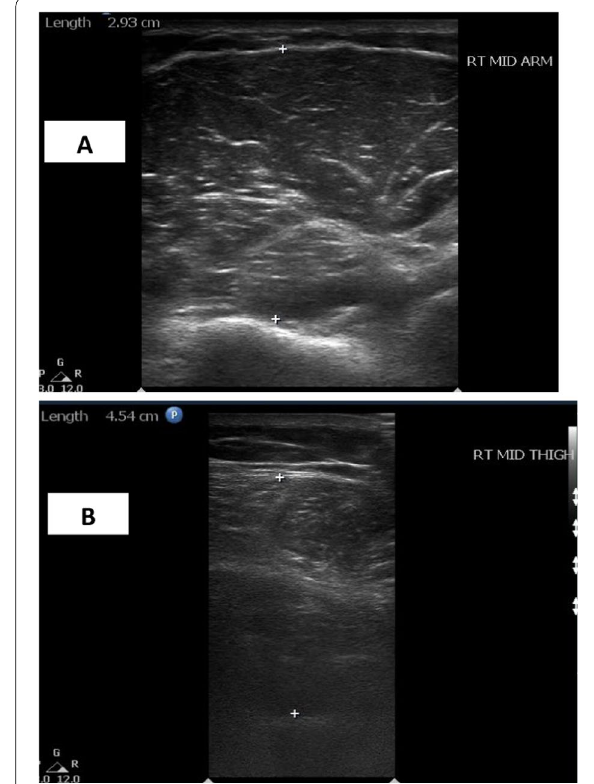
Fig. 8 A , B A male, control subject 63 years old, BMI 23.6, HGS: 35. A USG mid upper arm of control, which positively correlated with HGS. B USG mid‑thigh of control, which correlated positively with HGS